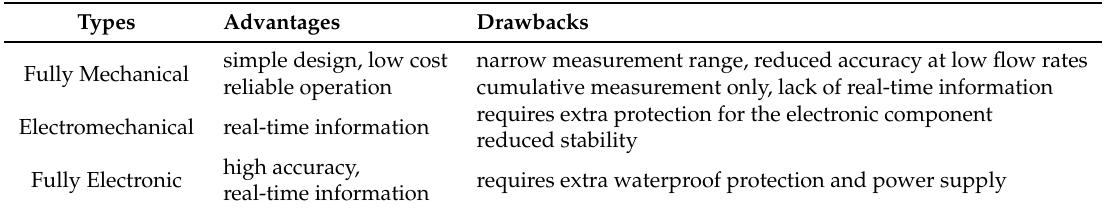
Table 1. Comparison of water